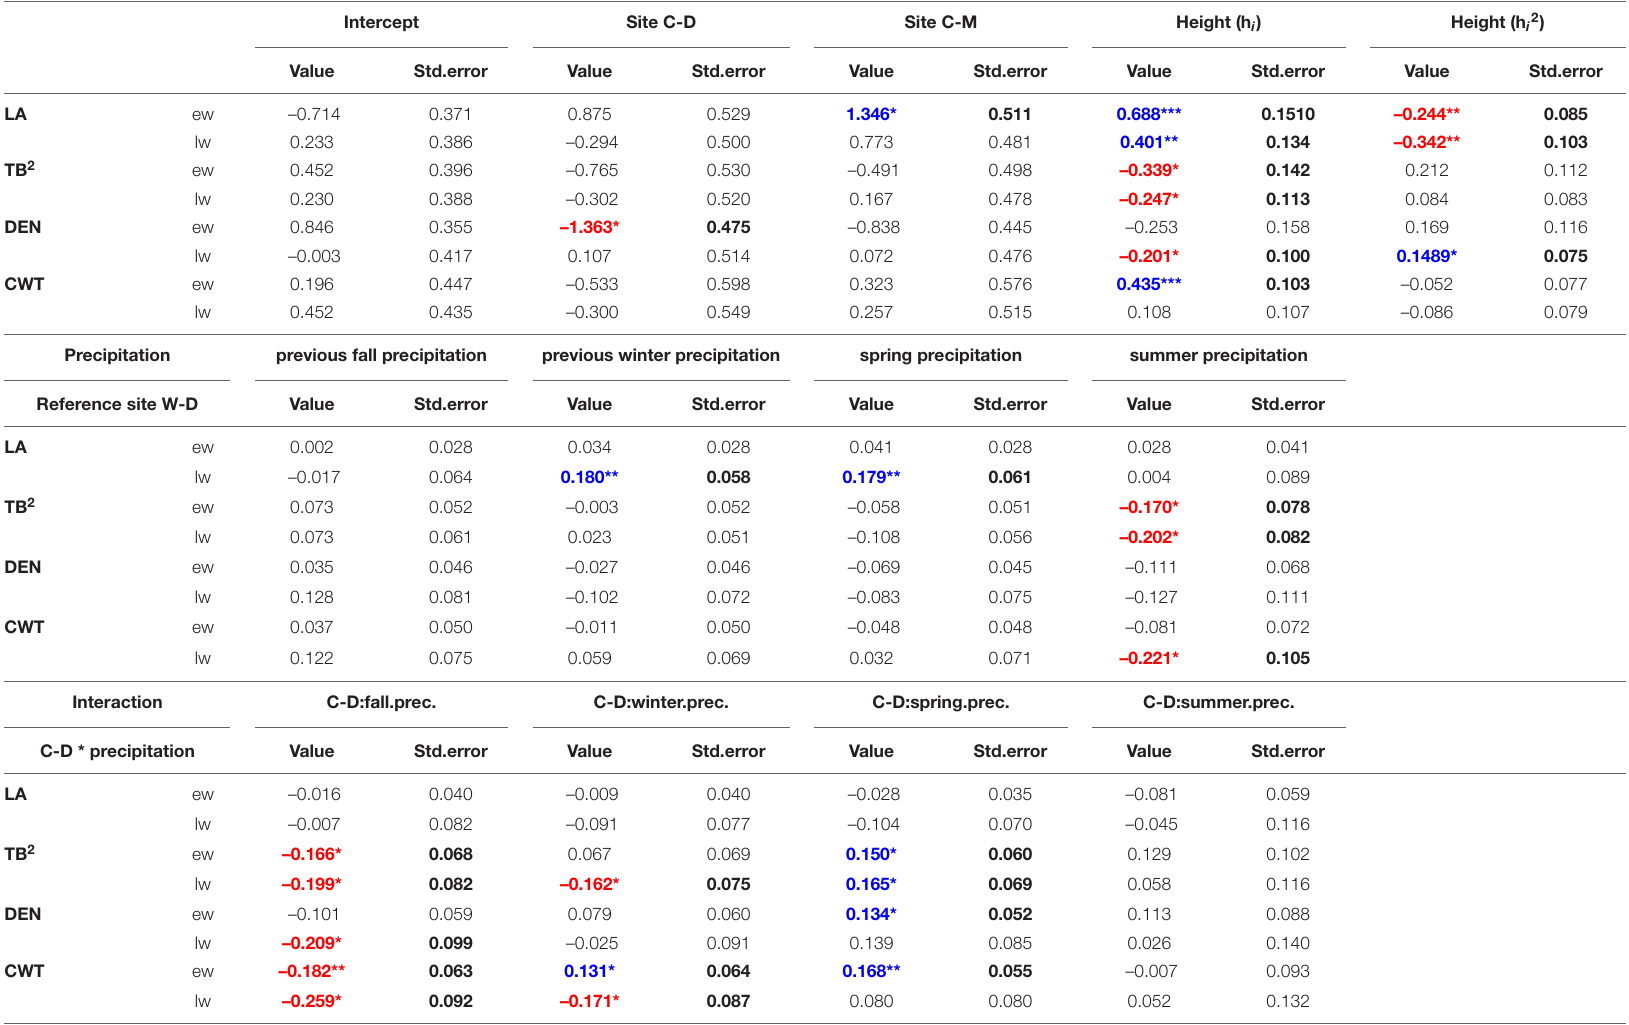
TABLE 1 | Results of trait specific linear mixed-effects models for the investigated traits (LA, lumen area ; TB 2 , conduit reinforcement index ; DEN, density ; CWT, cell wall thickness) divided into earlywood (ew) and latewood